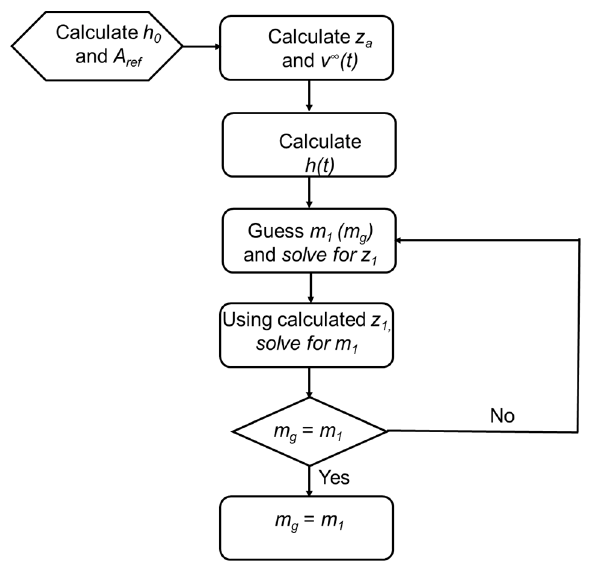
Figure A9. Flow chart for evaluation of m 1 and z 1 by iterative process.